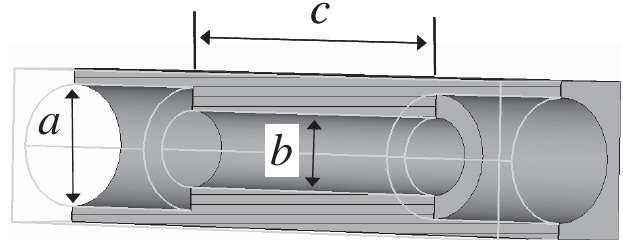
FIG. 6. The round stepped